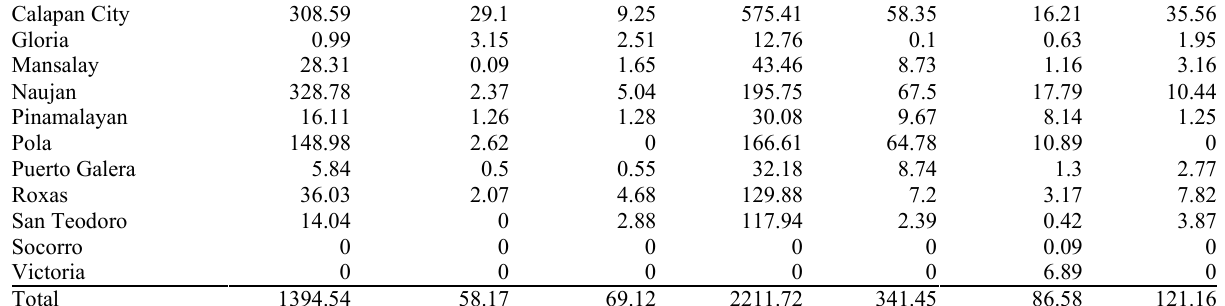
Table 9. Decadal Mangrove cover change pattern (in ha) in Occidental Mindoro. Note: M symbolizes the existence of mangroves, NM otherwise.